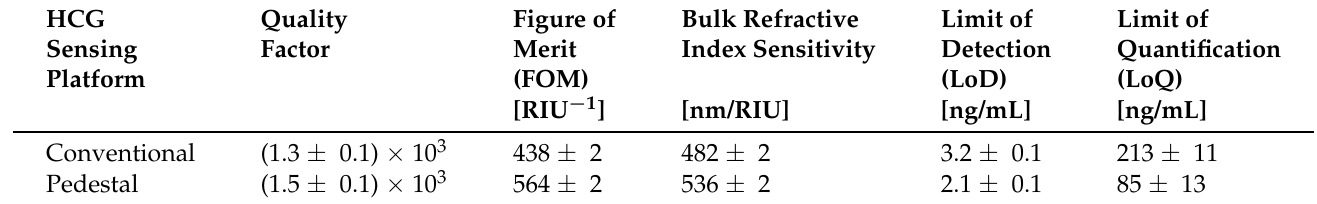
Table 1. Summary of the measured sensing performance of conventional and pedestal